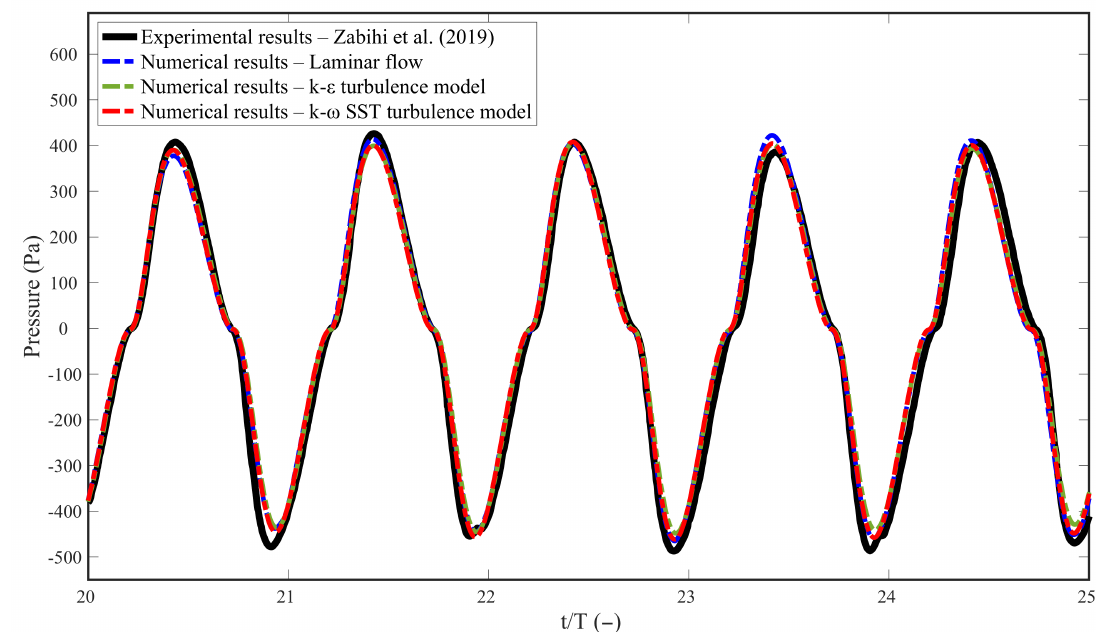
Figure 19. Air pressure inside the hydropneumatic chamber, experimental versus numerical